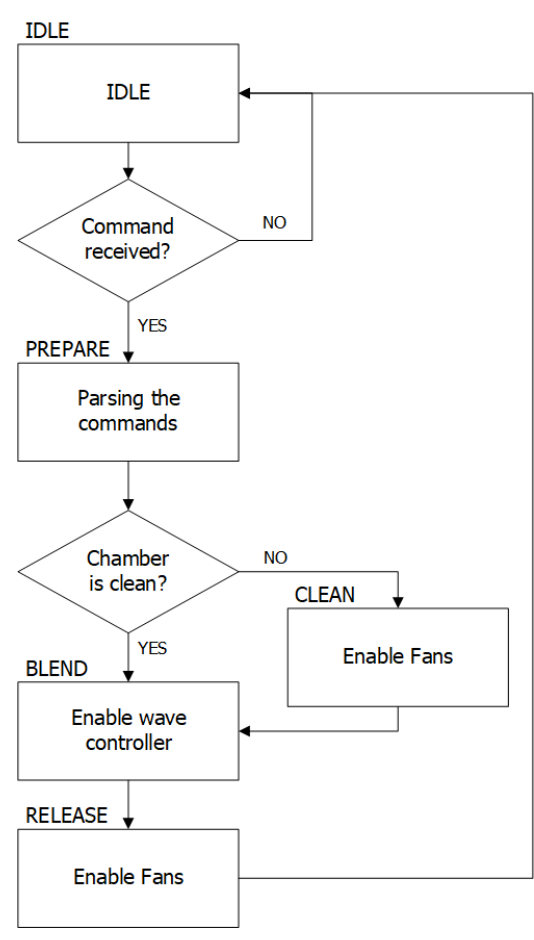
Figure 5. Finite state-machine of the firmware.